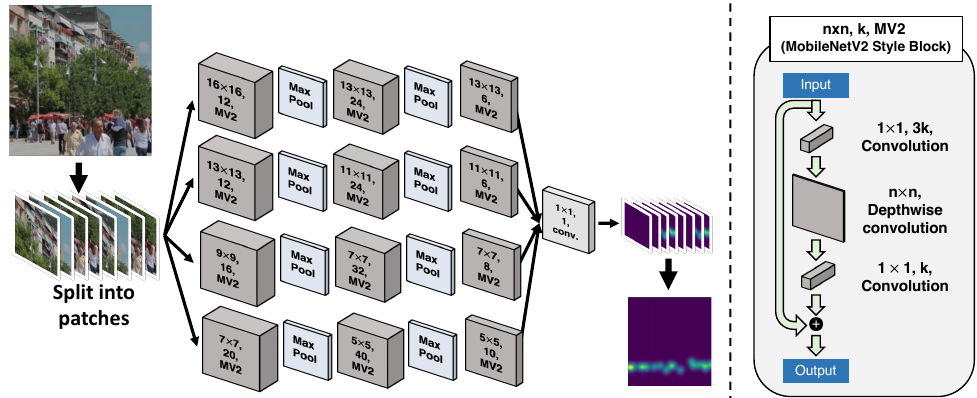
Figure 7. Architecture of MiCrowdNet. An input image is sliced into patches. The dark gray blocks represent the MobileNetV2 (MV2) style blocks [25]. MV2 consists of three sequential convolution layers. After passing the network, slices of the density map are produced.